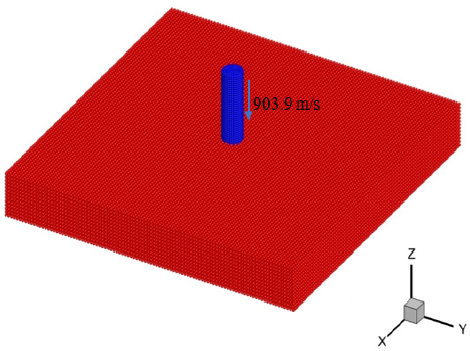
Figure 14. SPH model for high velocity impact of ceramic plate impacted by projectile.